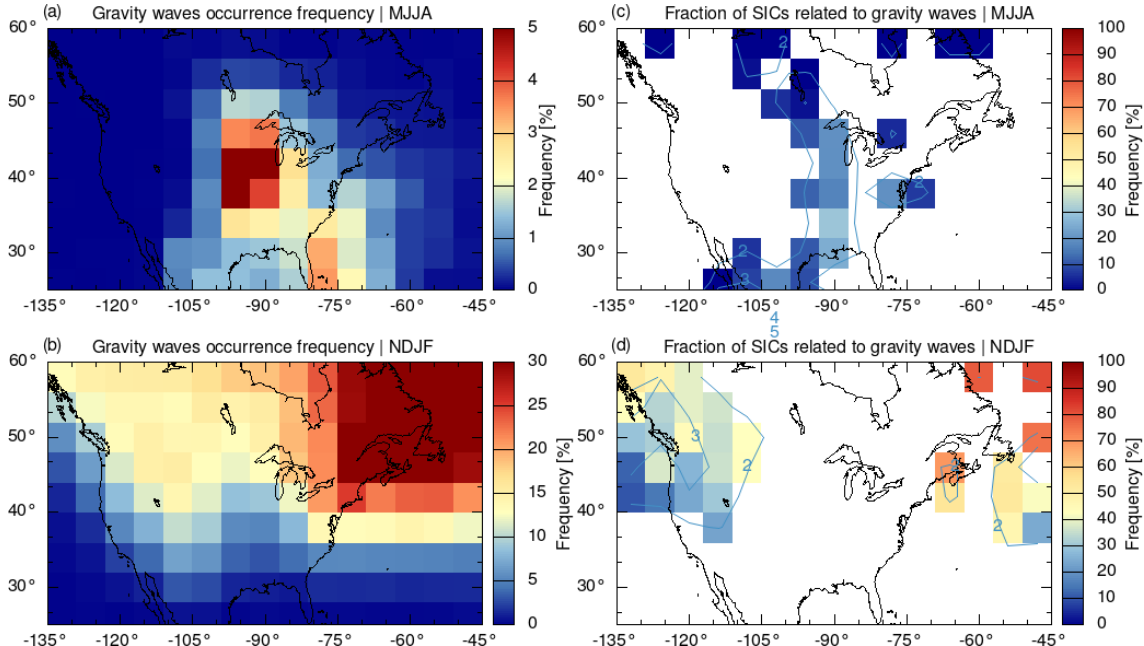
Figure 11. Mean occurrence frequency of gravity waves derived from AIRS measurements between 2006 and 2018 in MJJA (a) and NDJF (b) . Fraction of SICs related to gravity waves in MJJA (c) and NDJF (d) ; here SICs are those indirectly related to deep convection as found in Fig. 7.The blue contour lines show the occurrence frequencies of SICs.